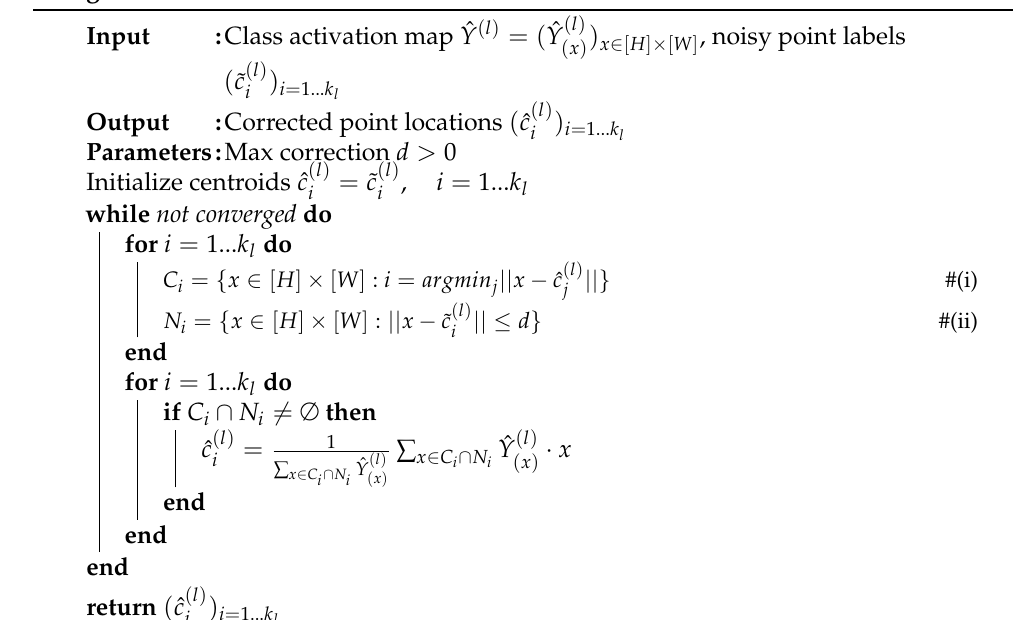
Figure 2. Detailed illustration of the proposed correction mechanism to learn class activation maps. Red and green crosses indicate noisy and corrected object locations, respectively. Dashed, red circles around red crosses show which pixels impact the correction of the respective object location. After applying Algorithm 1, corrected locations are exchanged with the partner branch and pixelwise targets are created to ultimately compute a pixelwise loss. Best viewed in color. Algorithm 1: Label